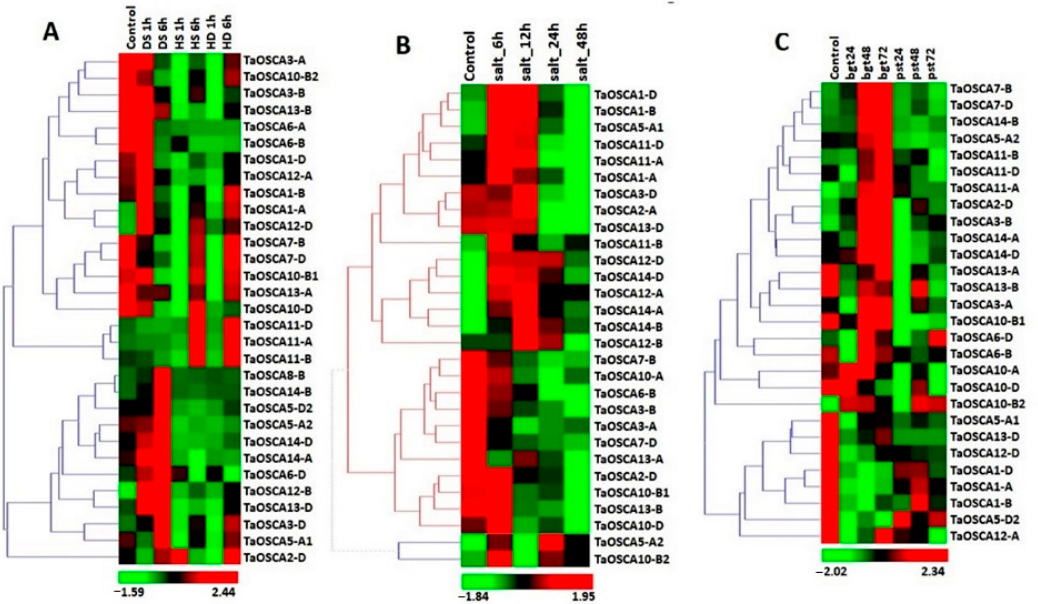
Figure 4. Expression profiling of OSCA genes of T. aestivum under abiotic and biotic stress conditions. Heat maps ( A – C ) show the expression profiles of two-fold up and down-regulated genes under ( A ) drought stress (DS), heat stress (HS), and HD (heat–drought), ( B ) salt stress, and ( C ) Blumeria graminis (Bgt) and Puccinia striiformis (Pst) infestation, respectively. The color bar shows high and low expressions with red and green color, respectively.